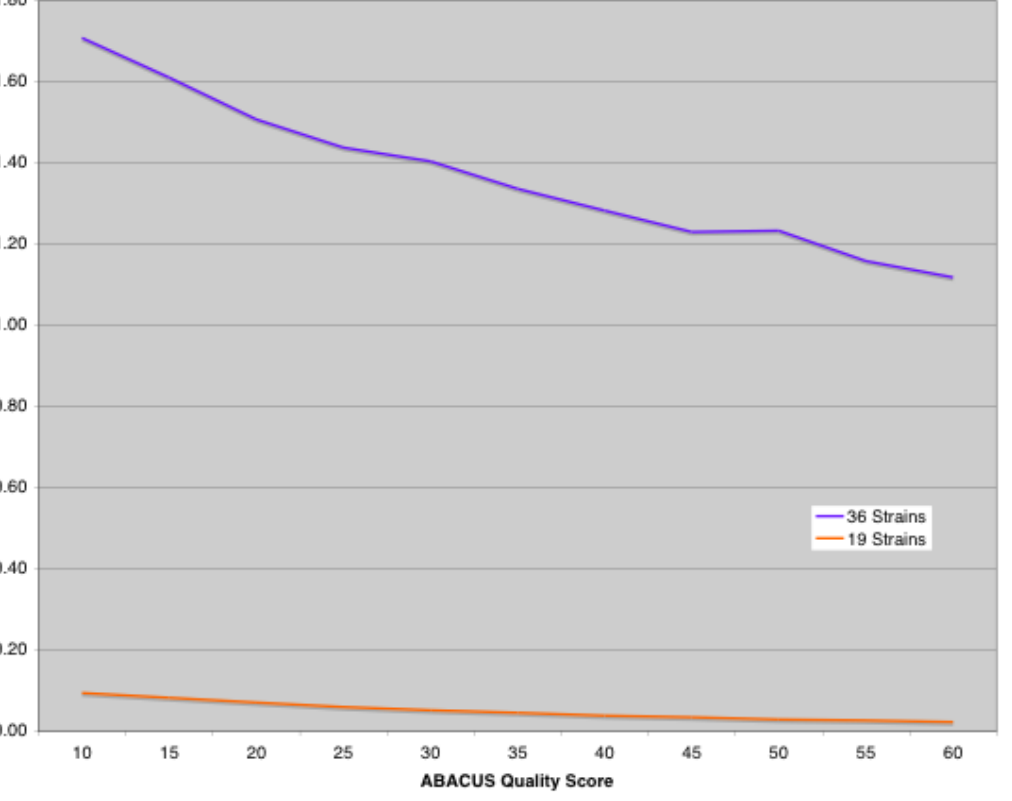
Figure 3. Graph shows relationship between multilocus sequence typing (MLST)/Resequencing Array(RA) tree distance and ABACUS quality score. doi:10.1371/journal.pone.0002513.g003 PLoS ONE | www.plosone.org